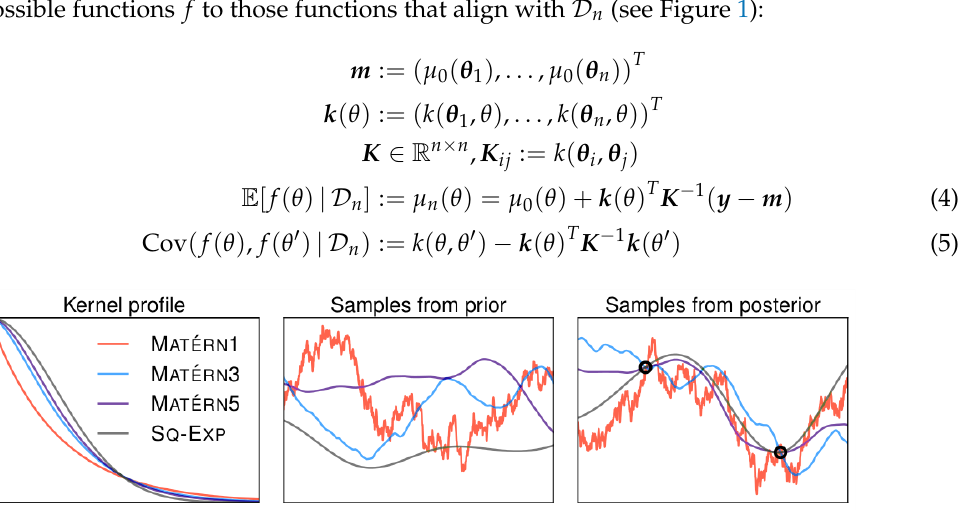
Figure 1. ( Left ) Comparison between different covariance kernels. ( Middle ) Randomly sampled functions f using those kernels. ( Right ) Random samples after two f values were observed and incorporated into the model via GP